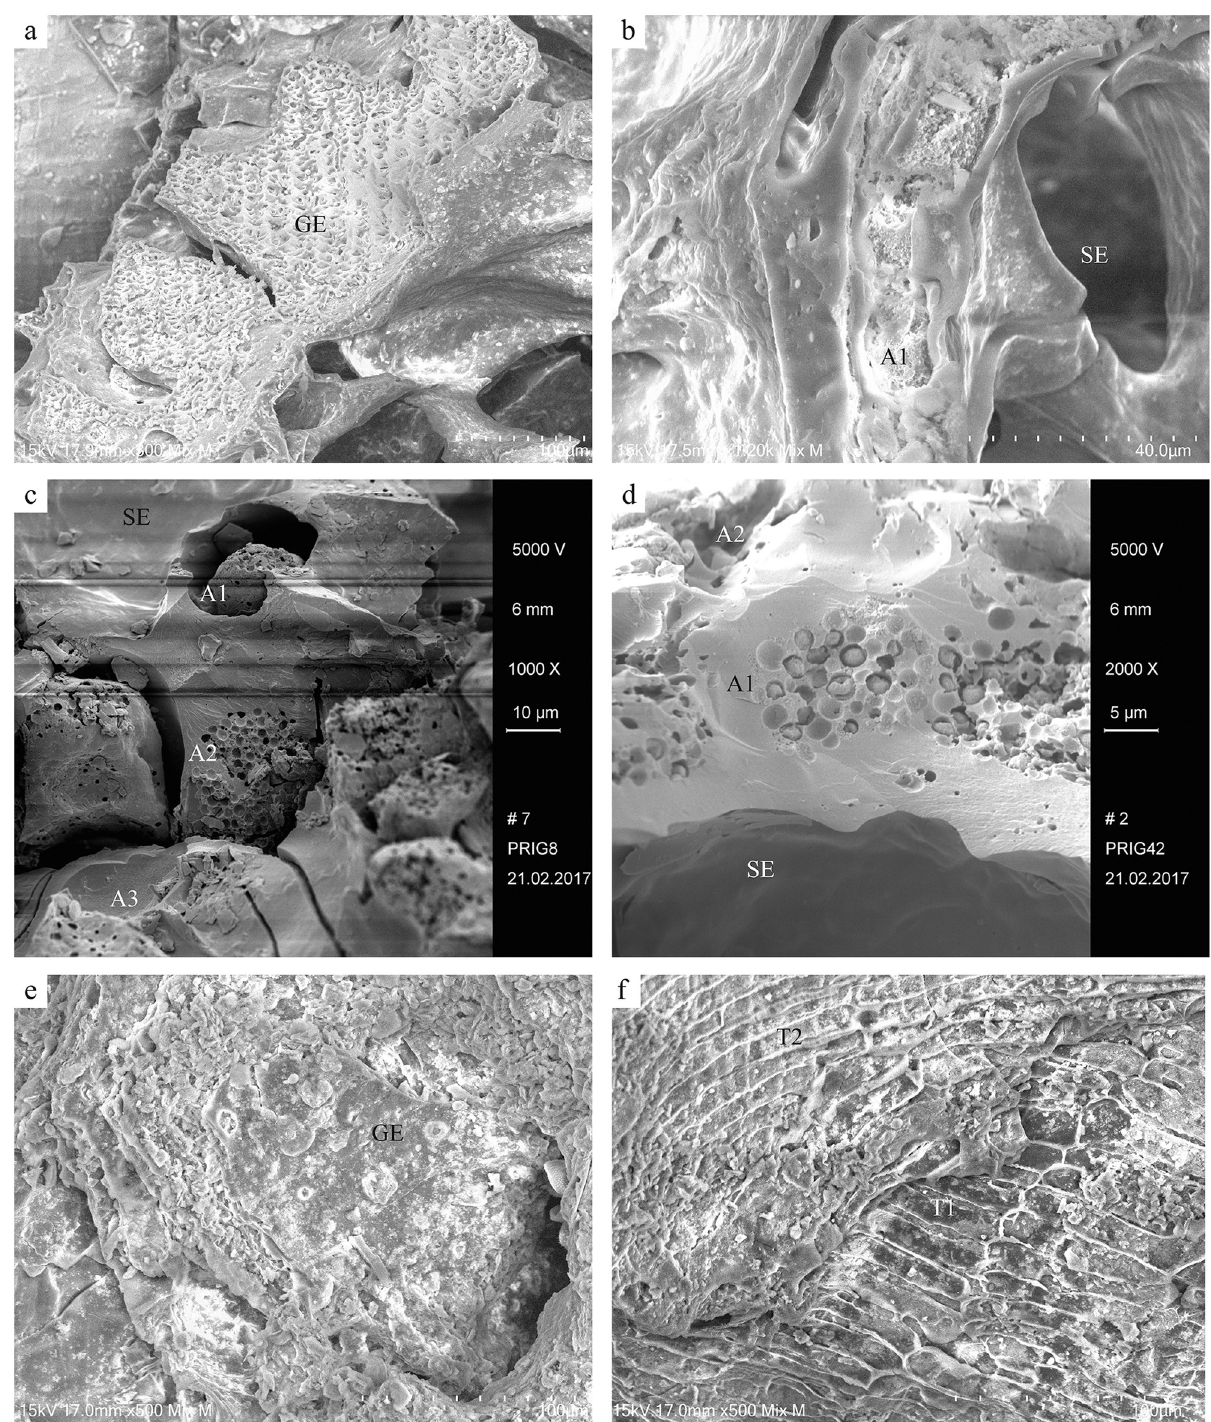
Fig 15. Selection of SEM micrographs of the cereal products from Prigglitz-Gasteil (see also Table 2). a) foxtail millet ( Setaria italica ) glume from find no. 0945, b) cereal (non- Hordeum ) aleurone from find no. 0945, c) barley ( Hordeum vulgare ) aleurone from find no. 0008, d) barley ( Hordeum vulgare ) aleurone from find no. 0042, e) hulled barley ( Hordeum vulgare ) glume from find no. 2148, f) barley ( Hordeum vulgare ) transverse cells from find no. 2153. Image labels: A1, A2, A3 ... aleurone layers, GE ... glume epidermis, SE ... fused starchy endosperm, T1, T2 ... transverse cell layers. Images: OeAW-OeAI/A. G.